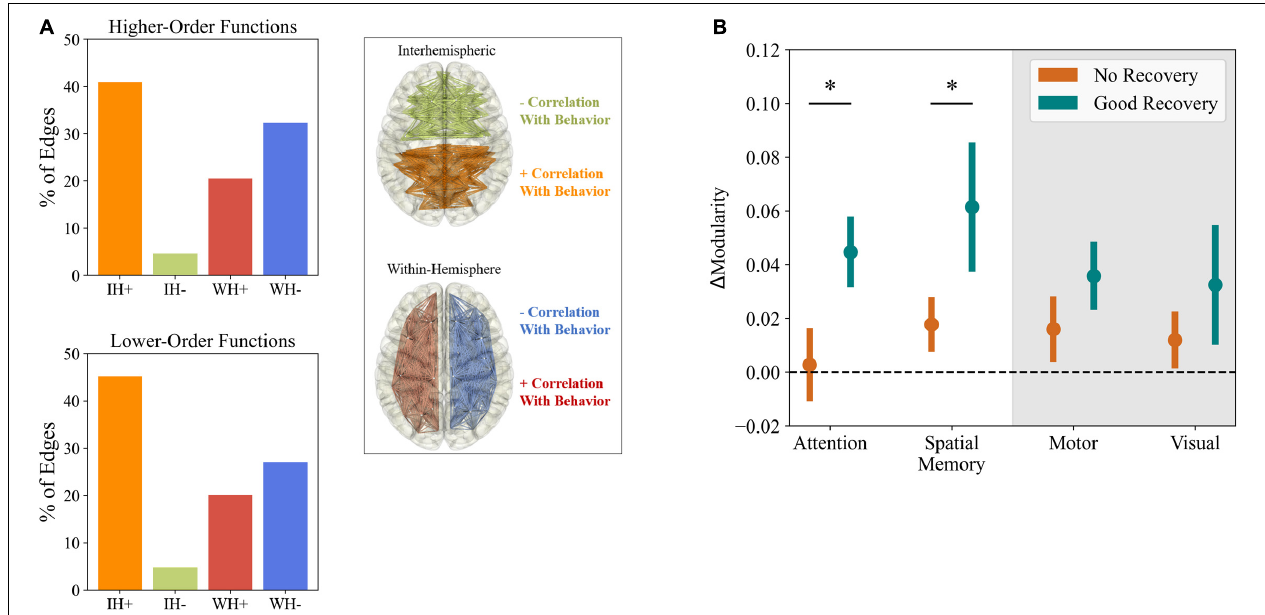
FIGURE 1 | Post-stroke changes in functional connectivity. (A) Predictive value of disruptions in functional connections for different behavioral deficits. The bar charts represent the percentage of connections, from the top 200 predicting behavior, belonging to each of the four groups described in the right (e.g., a percentage of 30% of IH+ means that increases in interhemispheric connectivity represent 30% of the 200 FC changes that best predict behavior). Notably, the strongest predictors of performance were increased interhemispheric connectivity and decreased intrahemispheric connectivity, both for higher (e.g., attention and working memory) and lower-order functions (e.g., motor and visual). Adapted from Siegel et al. (2016). (B) Correlation between changes in modularity and functional recovery. Patients with good behavioral recovery in higher-order functions, from attention to language, showed significantly higher changes in modularity than patients with poor recovery. The same pattern was not observed for motor and visual functions. (cid:49) Modularity represents the slope of a logarithmic fit to modularity at 2 weeks, 3 months, and 1 year. Adapted from Siegel et al. (2018). * Represents p < 0.05, from one-tailed unpaired t -test, after correction for multiple